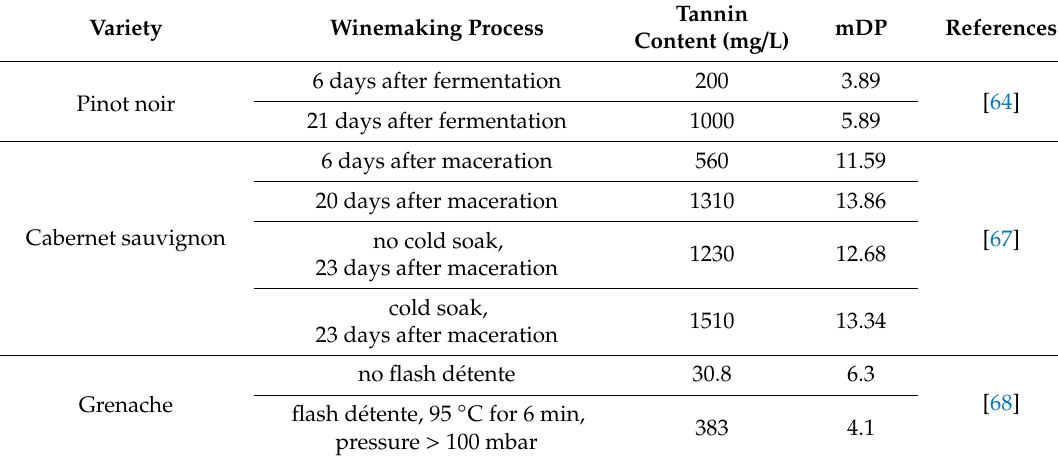
Table 4. E ff ect of wine production on wine tannin content and mean degree of polymerization (mDP) in Vitis vinifera and hybrid grape varieties. ND, not